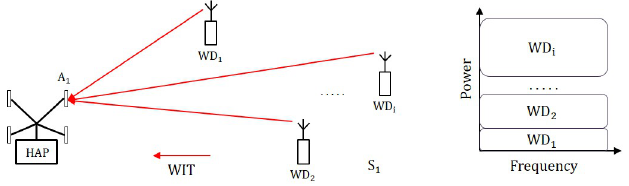
Figure 4. System model: NOMA.